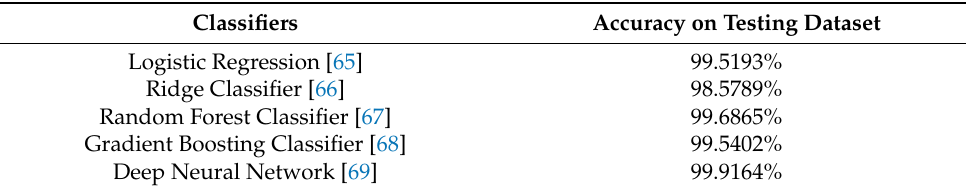
Table 5. Accuracy of emergency rescue recognition dataset on different